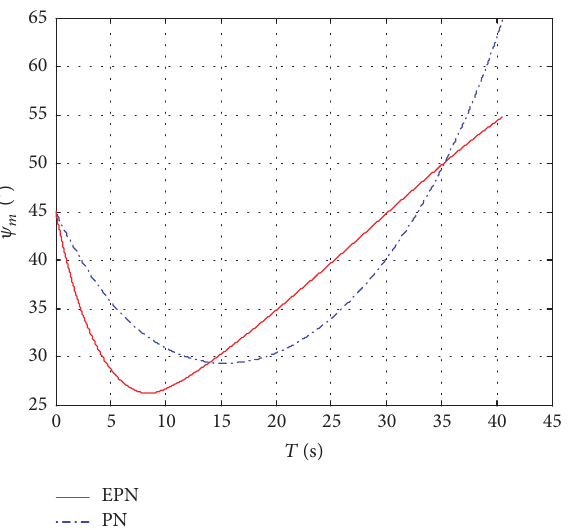
Figure 6: Time history of trajectory azimuth.